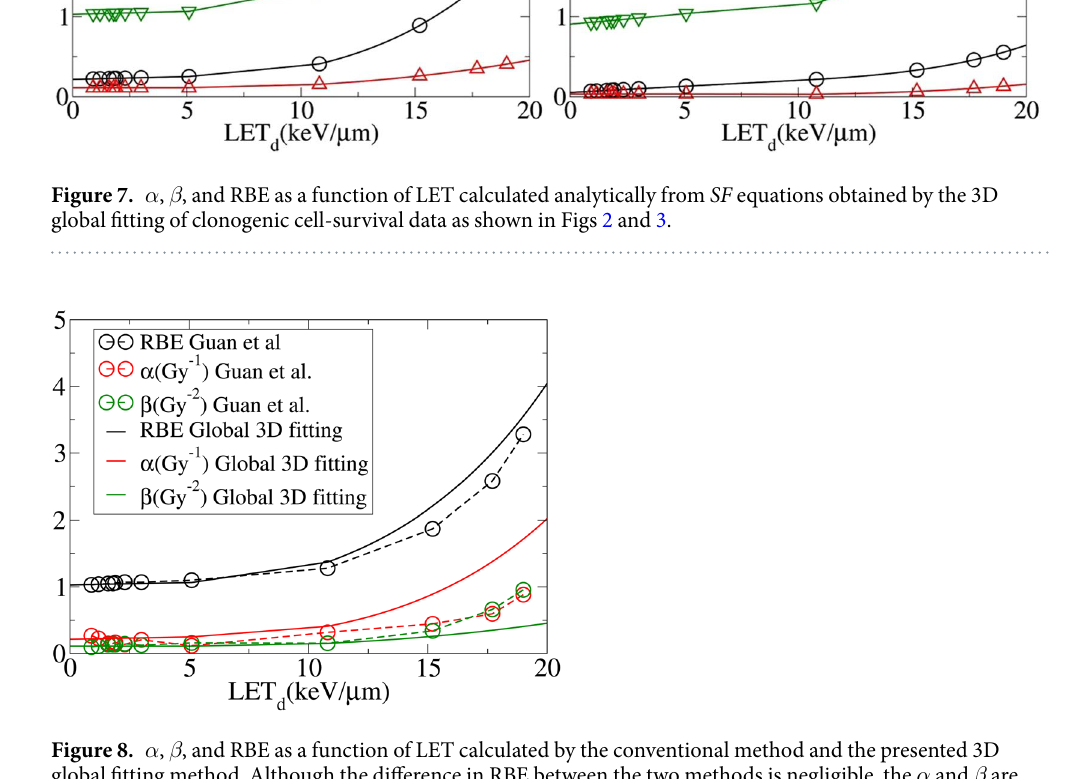
survival fraction data acquired after irradiation with mono-energetic proton beams. In our approach, the intrinsic correlations in cell survival data are incorporated into the fitting algorithm. As a result, background fluctuations